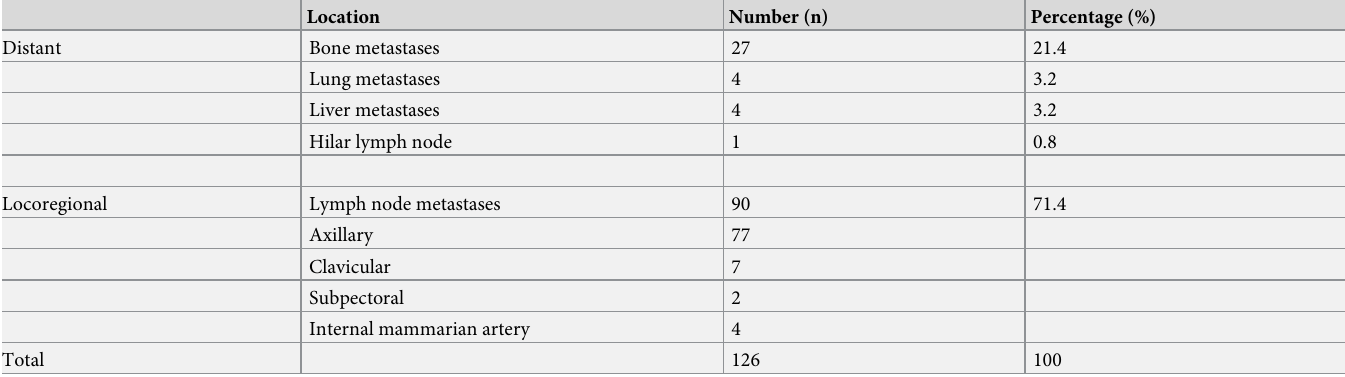
Table 3. Location of all 126 malignant lesions according to the standard of